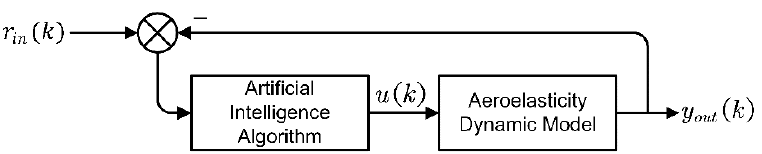
Figure 1. Schematic diagram of the control problem.